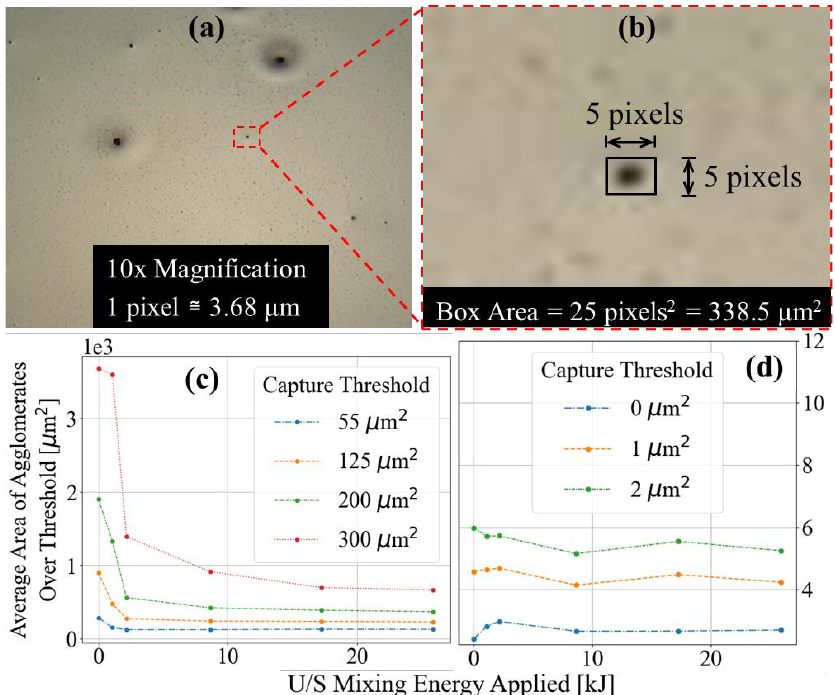
Figure 6. ( a ) Moderately mixed (2.16 kJ) nanocomposite film sample imaged at 10 × magnification and ( b ) enlarged to show pixilation of agglomerate features and their approximate dimensions. Plots of average agglomerate areas of samples with varied dispersion energy at ( c ) 10 × and ( d ) 100 × magnification.